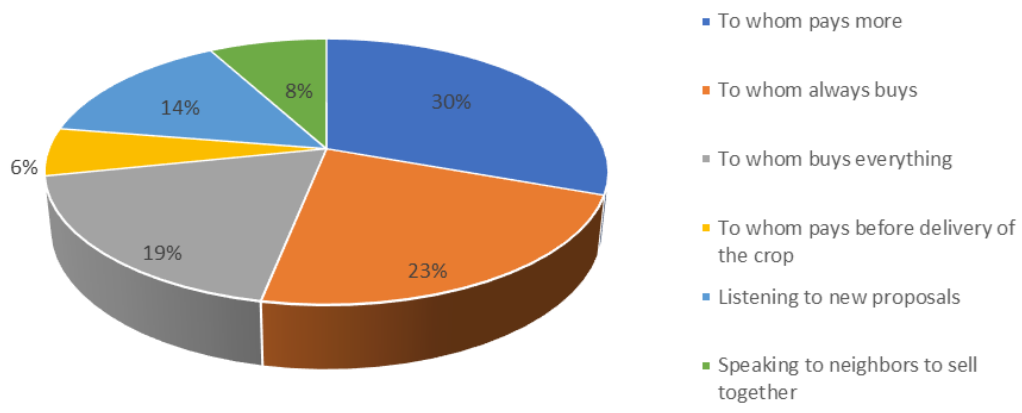
Figure 6. Features to choose the buyer.